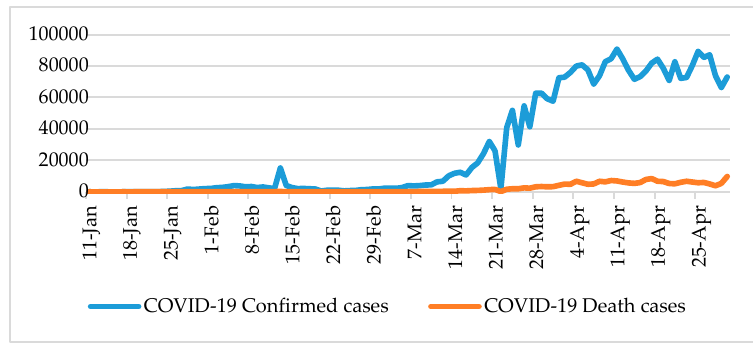
Figure 1. Global confirmed cases of and deaths from COVID-19 from 11 January to 30 April 2020.